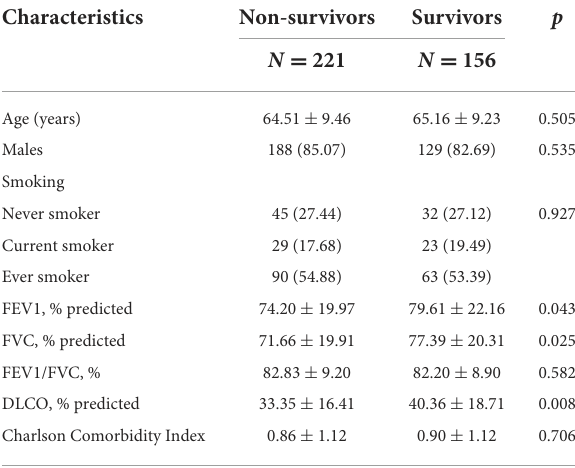
TABLE 1 Baseline characteristics of patients with IPF in the derivation cohort.